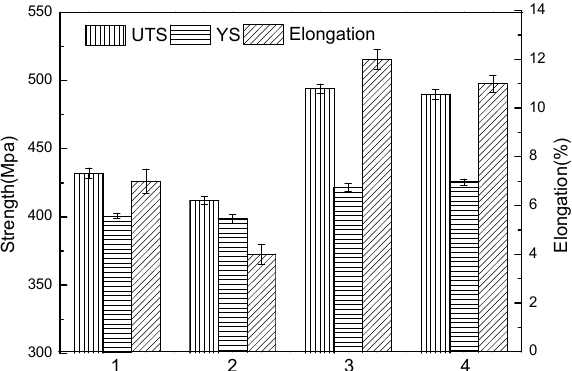
Figure 7. Mechanical properties of single-wire and double-wire wall: ( 1 ) transverse of single-wire; ( 2 ) longitudinal of single-wire; ( 3 ) transverse of double-wire; and ( 4 ) longitudinal of double-wire.